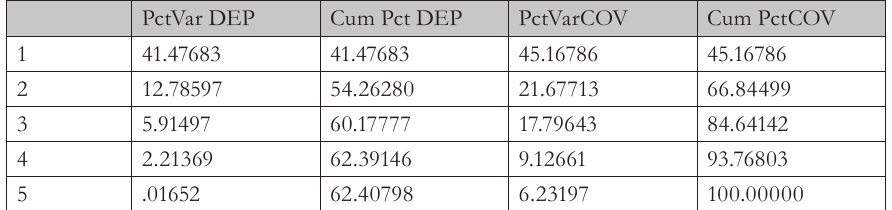
Tab. 6 – Covariates’ variance explained by canonical variables. Source: own research